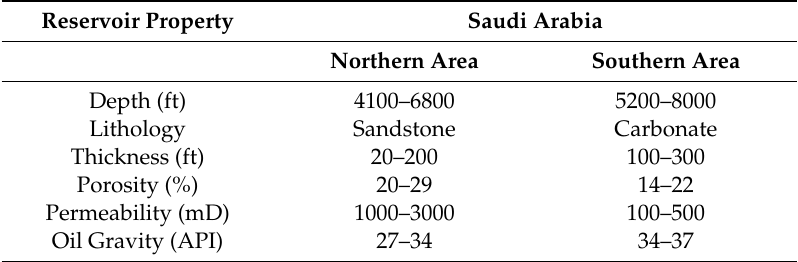
Table 7. General oil reservoir conditions for Saudi